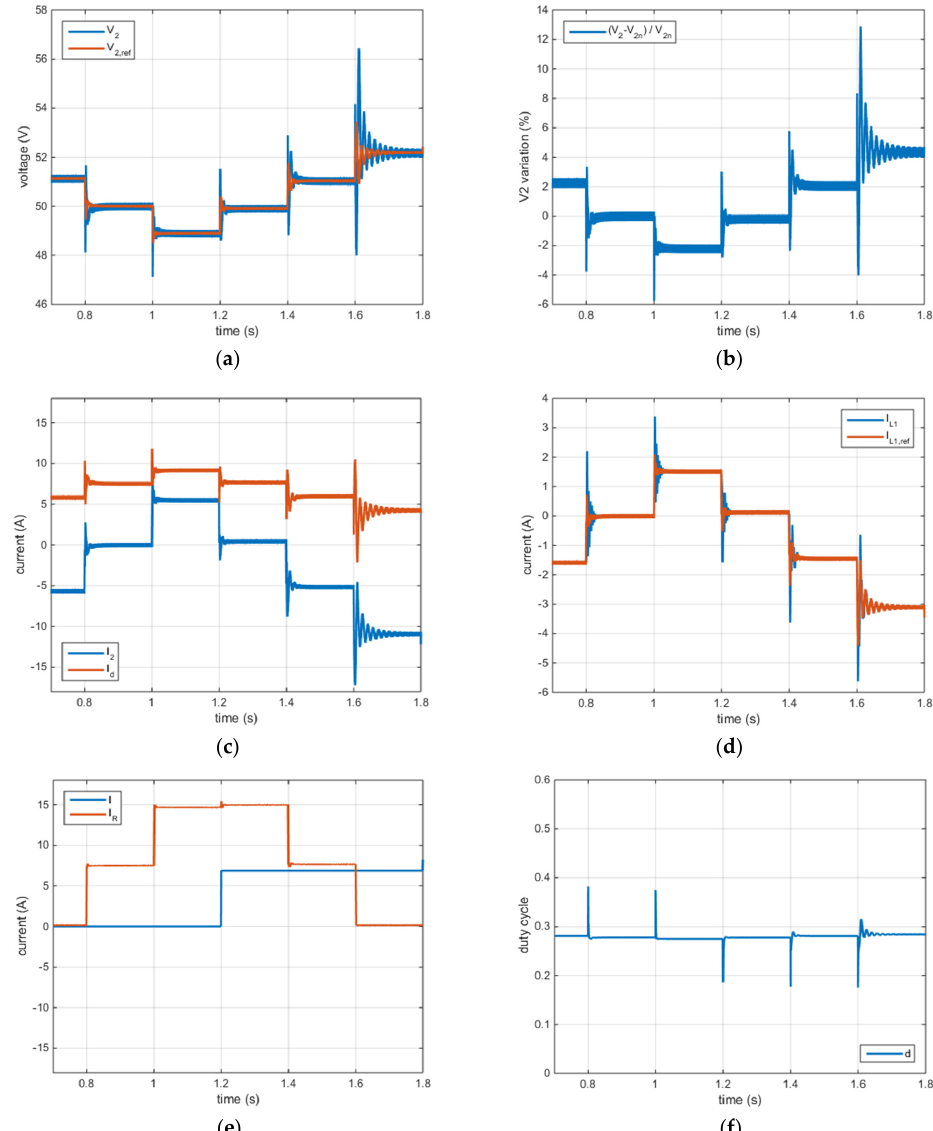
Figure 8. Simulation results in scenario #3 (SD − GD): ( a ) grid voltage and its reference; ( b ) grid voltage variation; ( c ) output current and voltage generator’s current; ( d ) input inductor current and its reference; ( e ) external generator’s current and load current; ( f ) duty cycle.